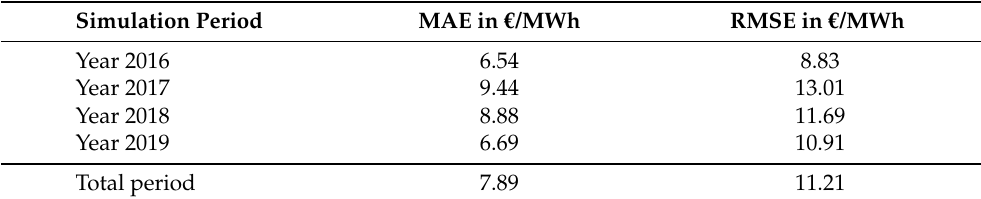
Table 3. Error metrics and obtained values for different simulation